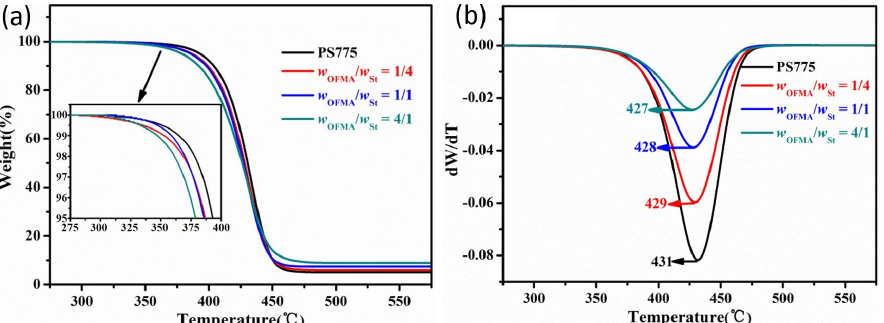
Figure 6. TGA ( a ) and DTG ( b ) curves of PS spheres and PS/P(OFMA-S) particles.